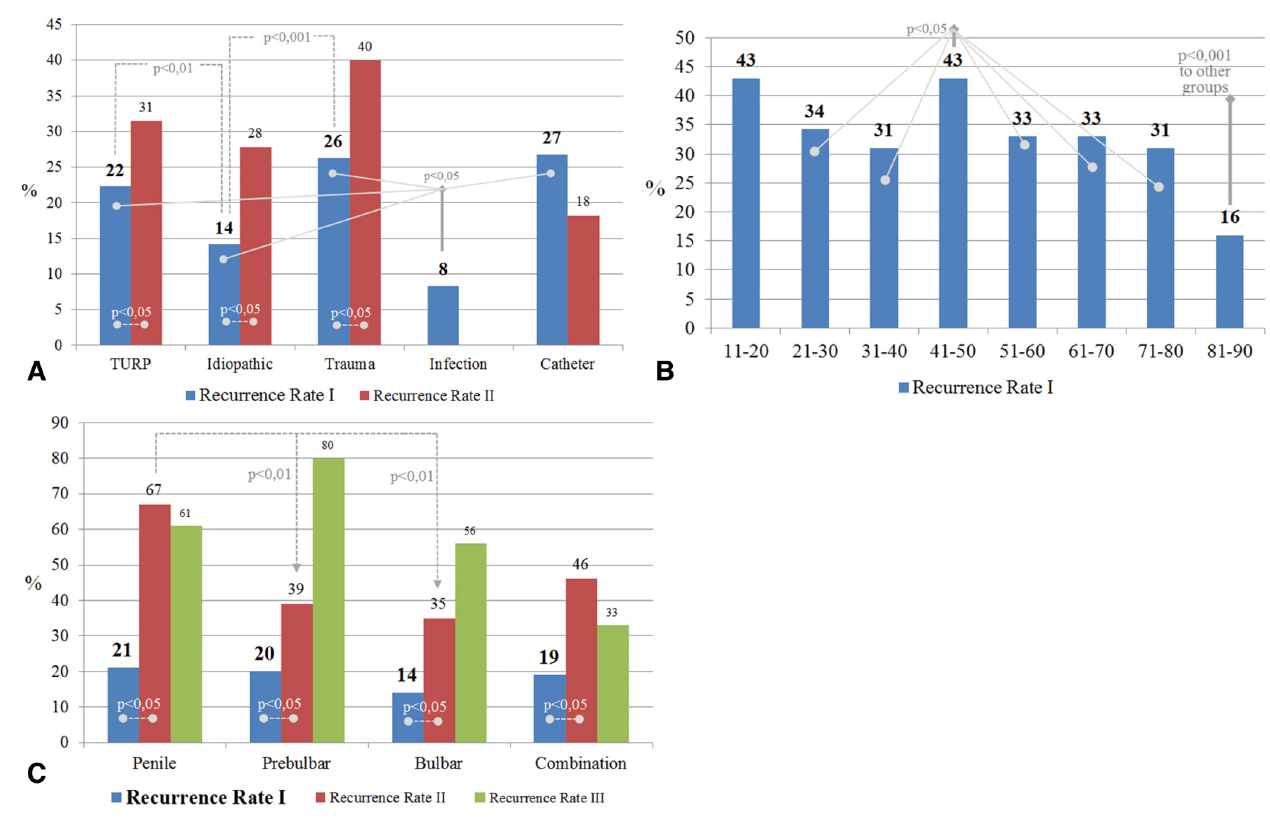
Figure 3. Recurrence rate after optical internal urethrotomy in patients with urethral stricture disease (Cohort I). A - Recurrence rate with respect to the etiology after the 1 st and 2 nd urethrotomies. B - Recurrence rate with respect to the patient age after the 1 st urethrotomy. C - Recurrence rate with respect to the stricture location and number of consecutive procedures (1 st , 2 nd and 3 rd ).